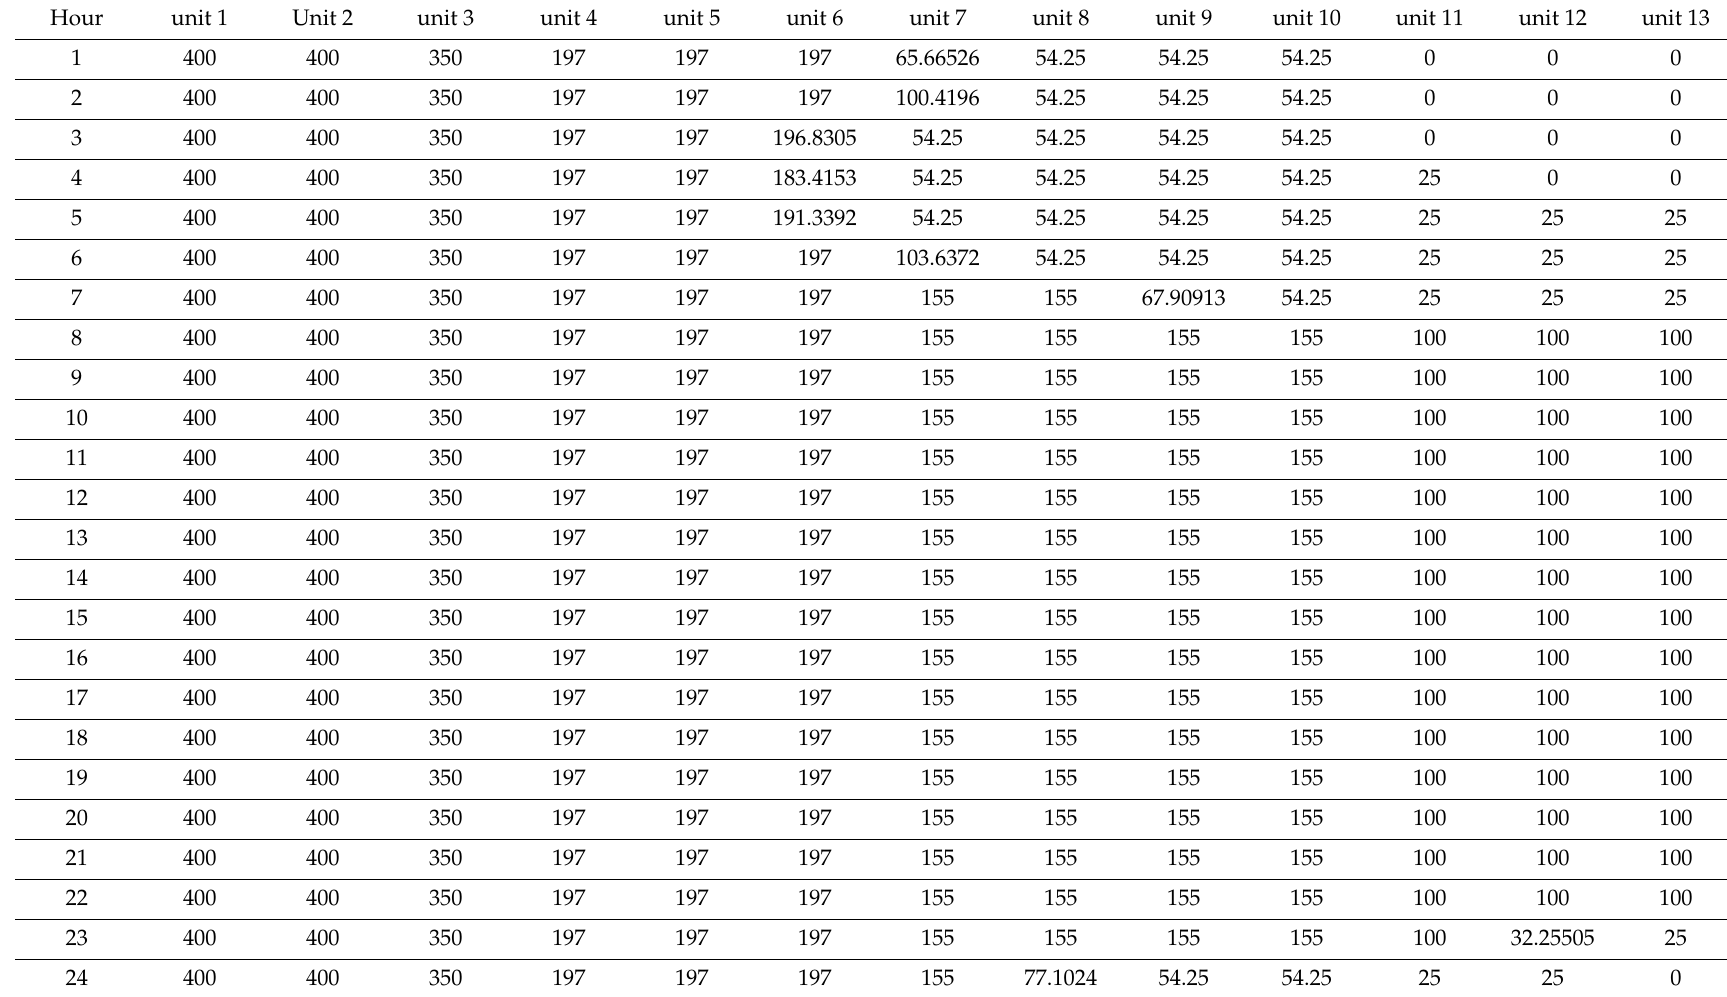
Table 7. Unit commitment (UC) result